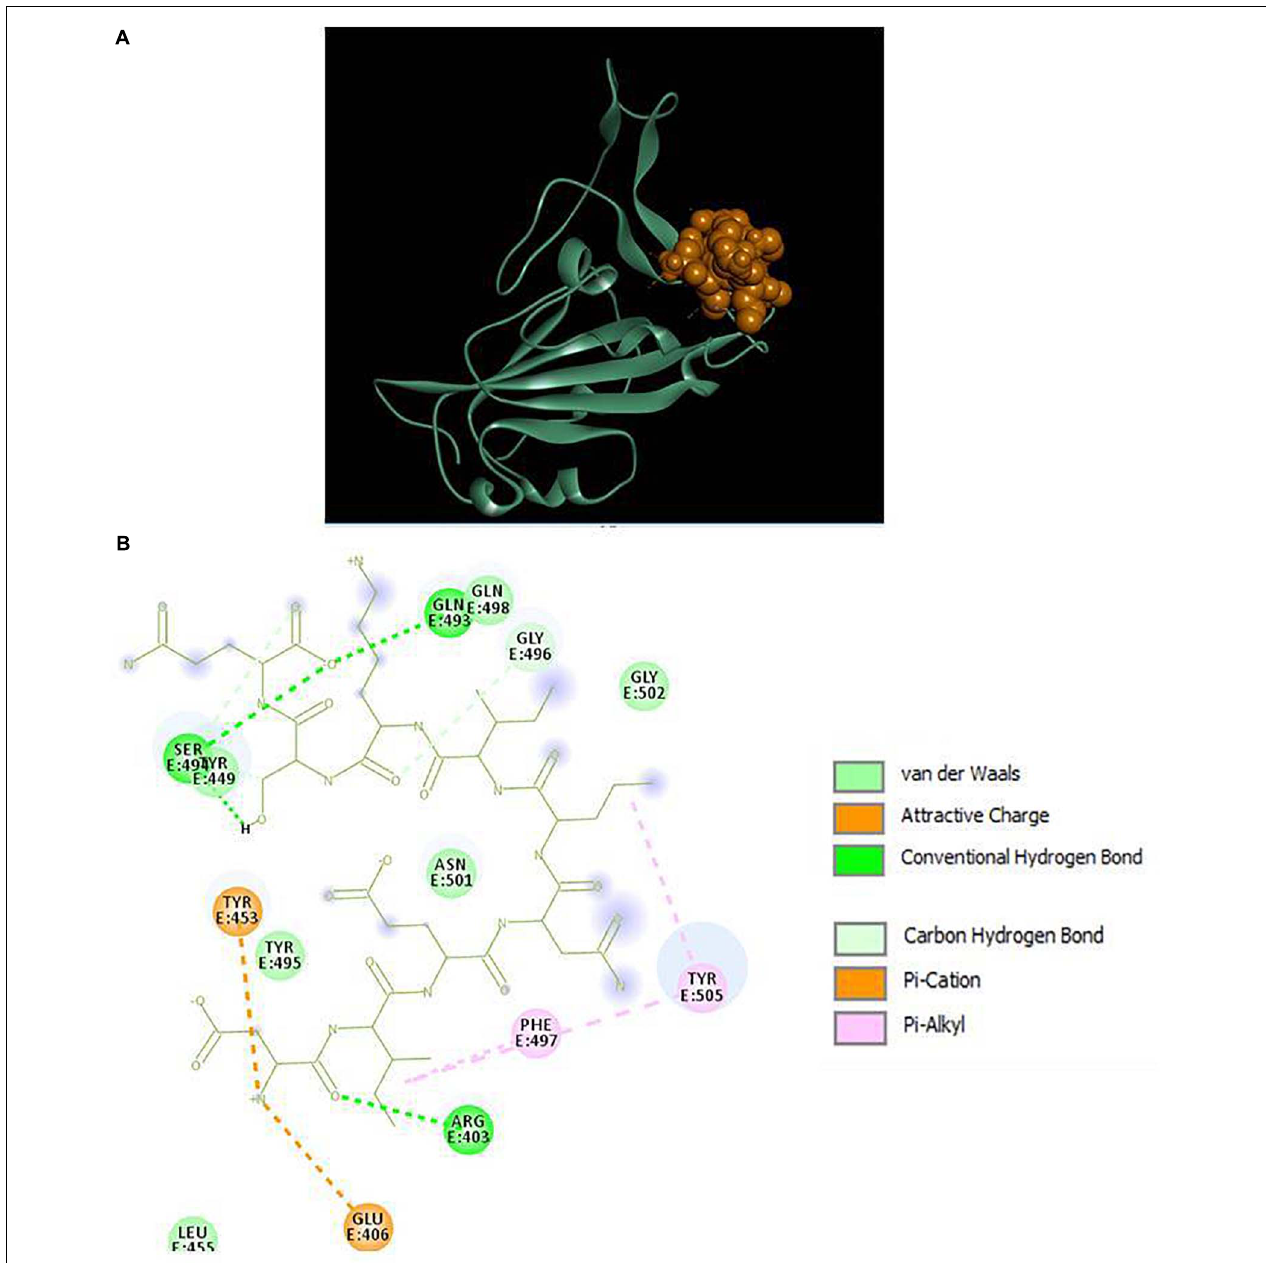
FIGURE 3 | (A) Docking of RBD (ribbon) and peptide P18 (CPK), (B) 2D representation of RBD-peptide interactions. GLN493 and SER494 are designated as critical to RBD-hACE2